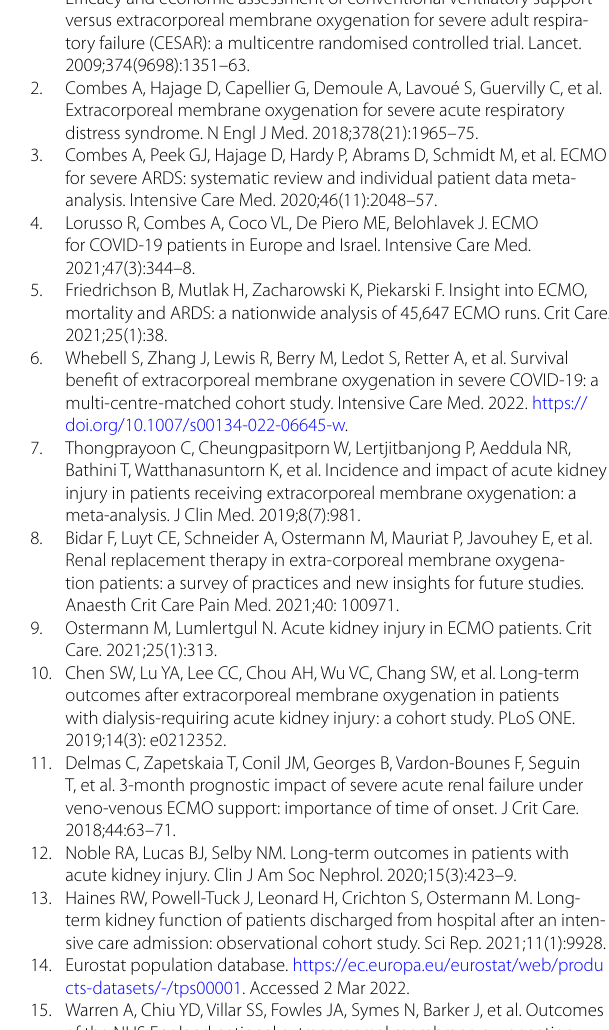
ECMO start year. Table S2. Relationship between ECMO start date and date of ICU admission. Table S3. Onset of AKI (n start date. Table S4. Timing of RRT initiation relative to ECMO start date